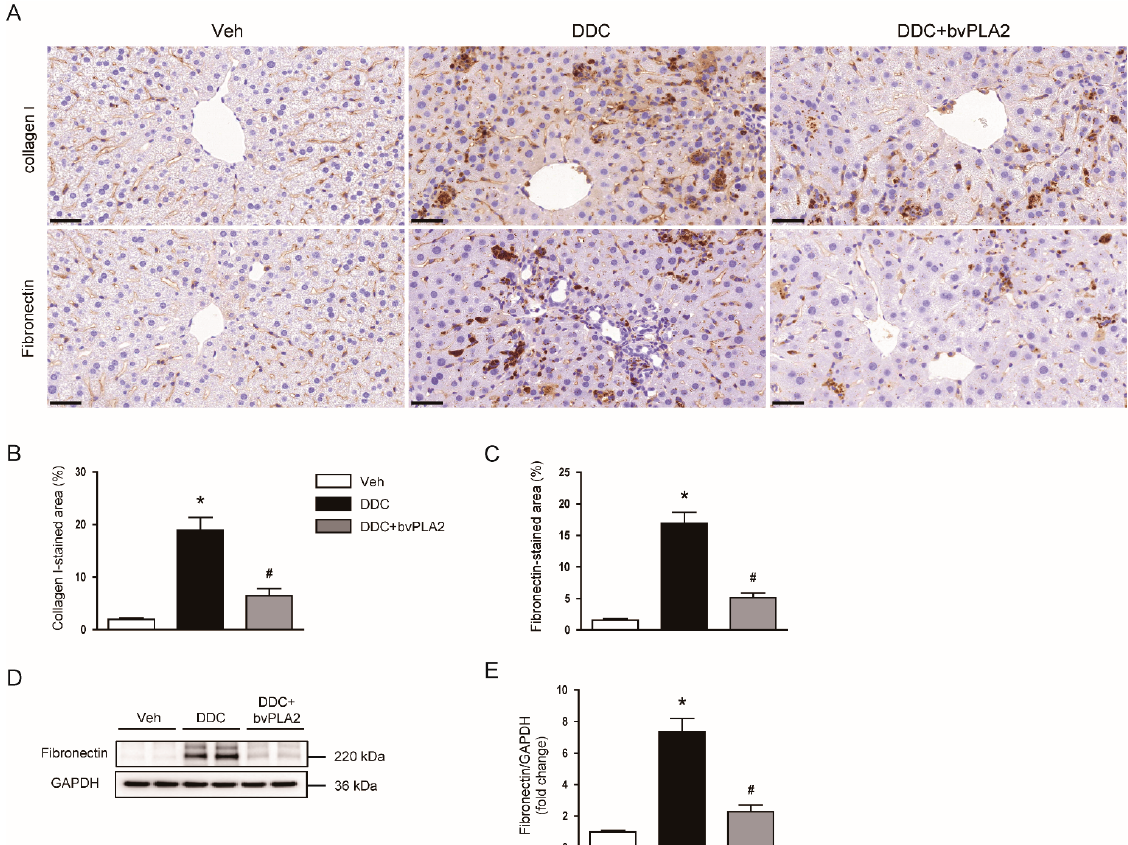
Figure 3. Effect of bvPLA2 on expression of extracellular matrix proteins in DDC diet-fed mice. ( A ) Immunohistochemical staining of liver tissues for collagen Ⅰ or fibronectin. Scale bar = 100 μ m. ( B ) Percentage of area stained with anti-collagen Ⅰ antibody. ( C ) Percentage of area stained with anti-fibronectin antibody. ( D ) Western blotting of fibronectin in liver tissues. ( E ) Quantification of western blots for fibronectin. n = 8 per group. * p < 0.05 vs. Veh. # p < 0.05 vs. DDC. Biomedicines 2021 , 9 , x FOR PEER REVIEW